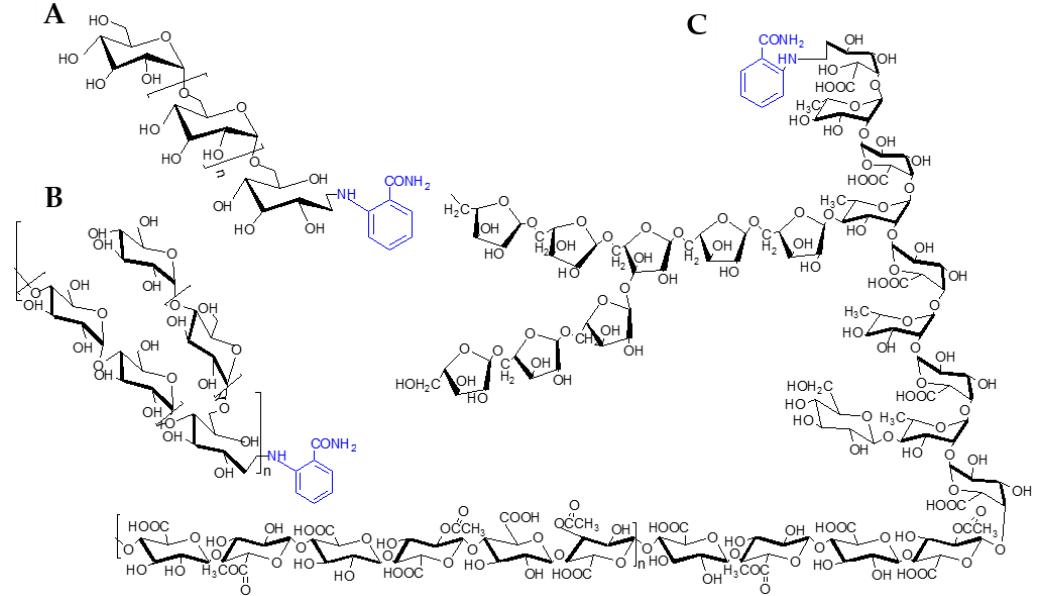
Figure 1. Schiff base reaction of 2-AB with glycan. Two fluorescent polysaccharides, PHP H-1-2 -2AB and PHP 0.5MSC-F -2-AB, were syn- thesized upon nucleophilic addition at the reducing terminus of PHP H-1-2 glucose or PHP 0.5MSC-F glucuronic acid with 2-AB and the reduction of the double bonds in the Schiff base NaBH 4 . The structures of the dextran reference substance, polysaccharide 0.5MSC-F, and H-1-2 derivatized with 2-AB are shown in Figure 2.